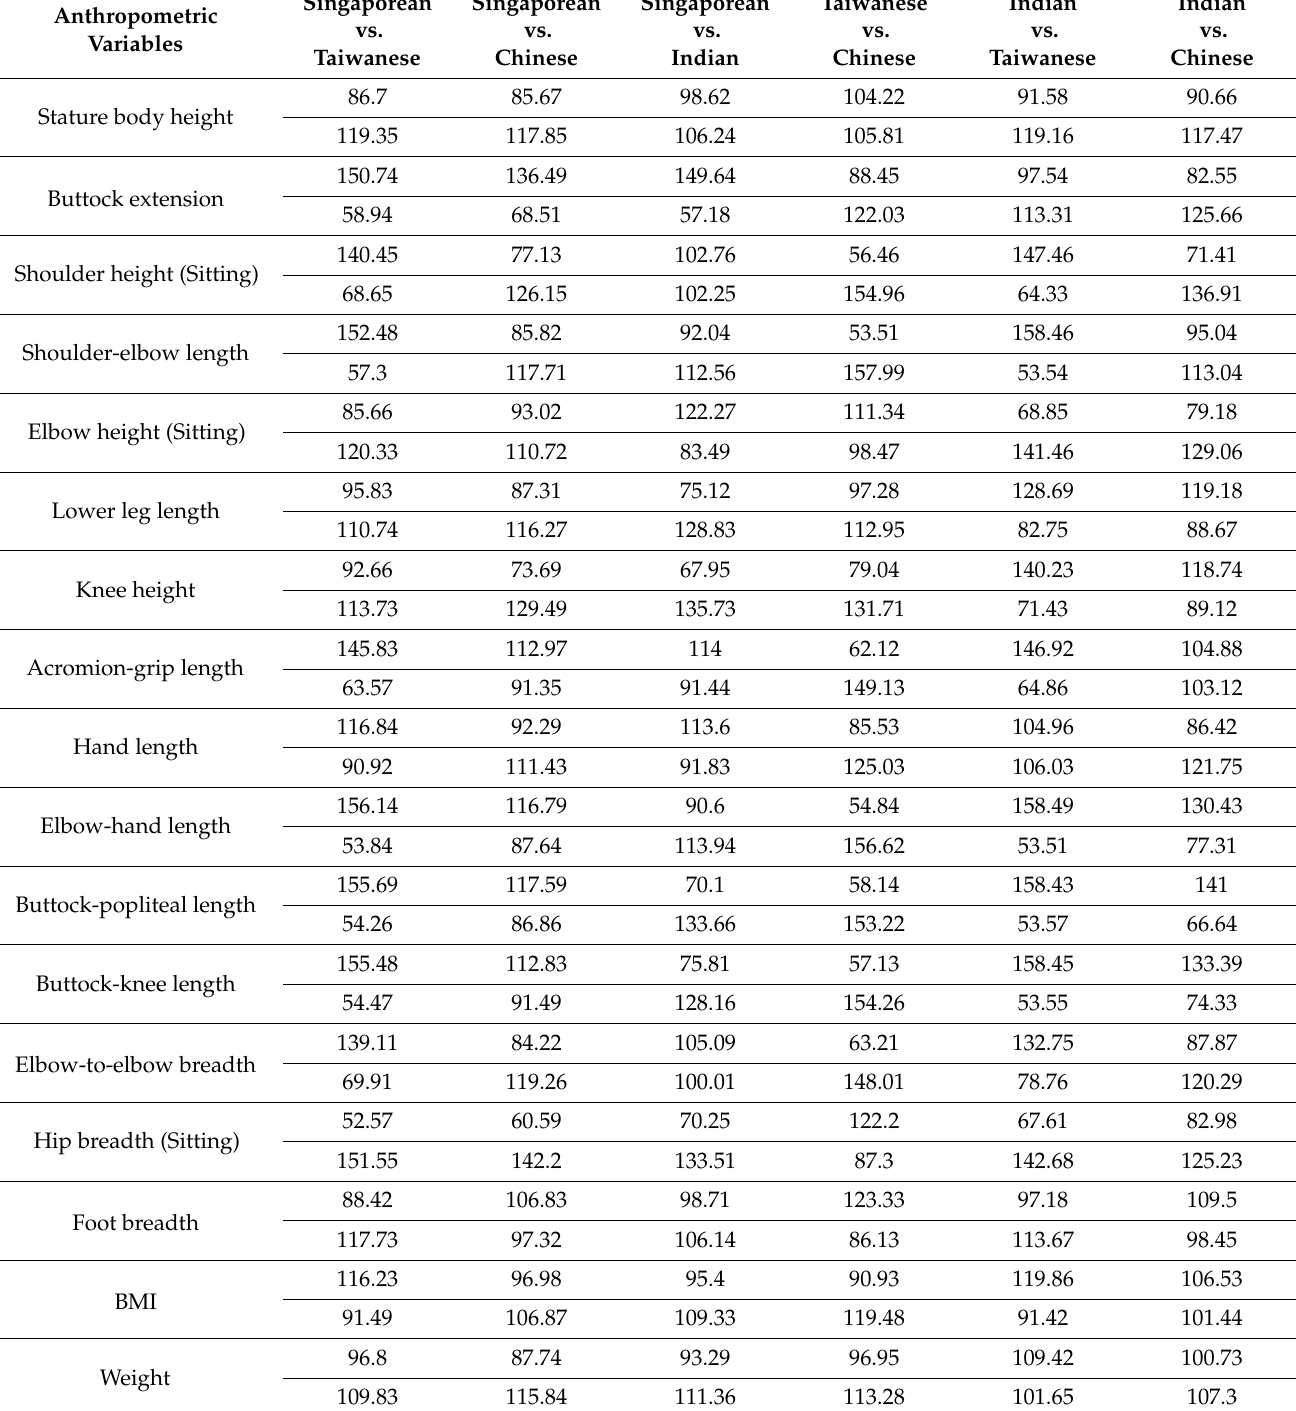
Table A2. Mean rank of Mann–Whitney